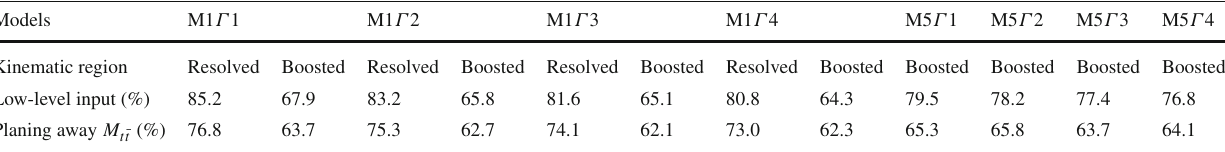
Table 5 The accuracy reach of the chosen neural networks before and after planing away M t ¯ t . The configurations of the DNN’s are listed in Tables 3 and 4